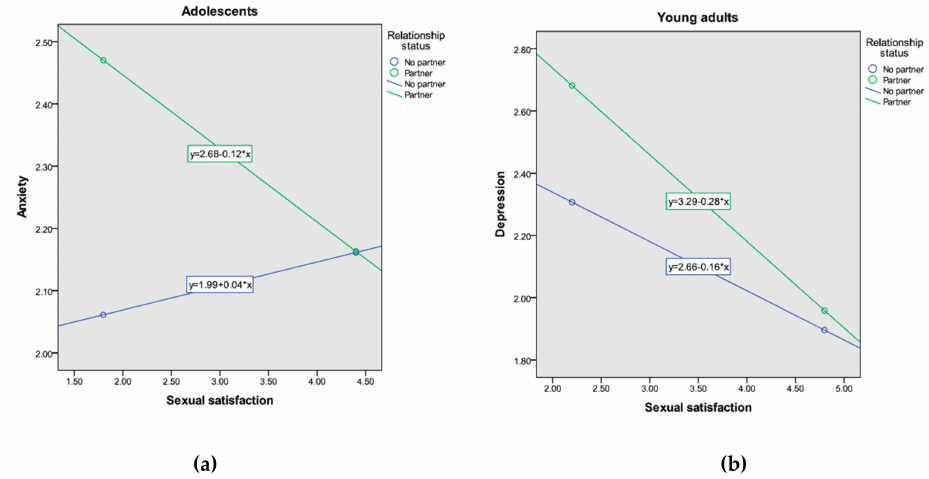
Figure 1. Sexual satisfaction × romantic relationship status interaction predicting mental health: ( a ) anxiety for adolescents; ( b ) depression for young